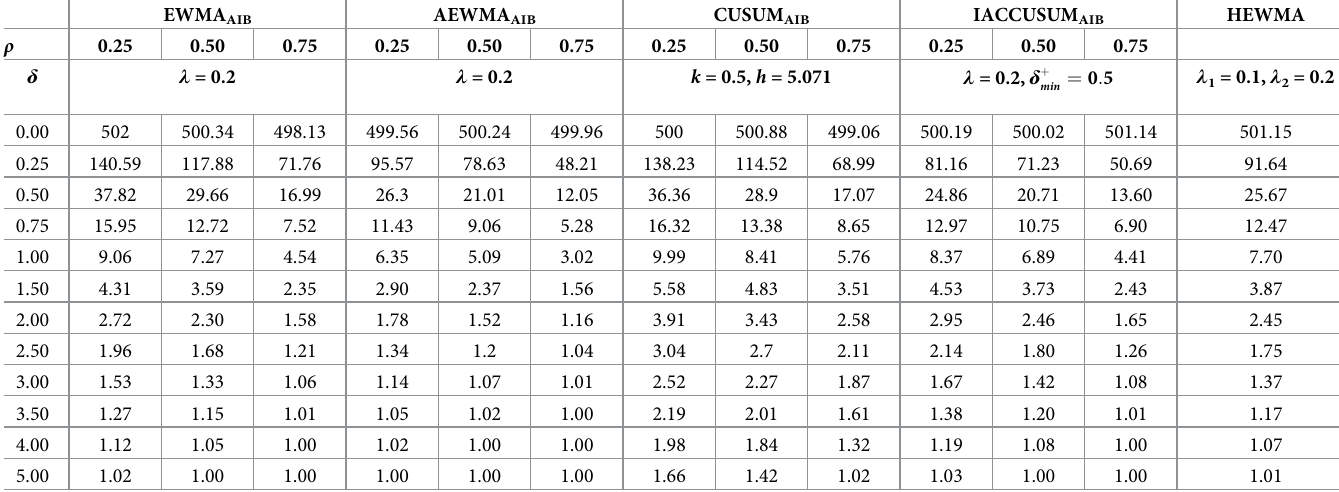
Table 4. The run length profile EWMA AIB , AEMWA AIB , CUSUM AIB , IACCUSUM AIB and HEWMA control charts at ARL 0 = 500.